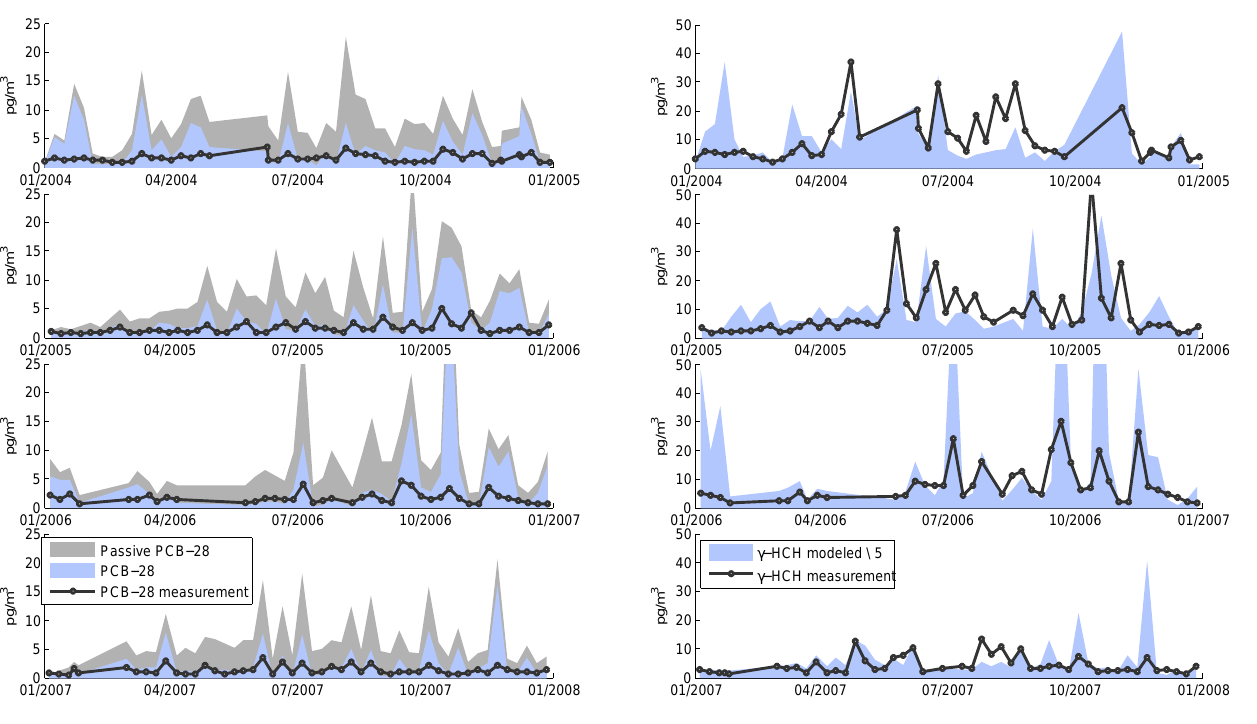
Fig. 5. Time series of modeled and measured PCB-28 [pgm − 3 ]. The grey area represents the concentrations of a passive PCB-28 tracer without removal processes, the blue area shows the modeled concentration of PCB-28 including removal processes, the black line with circles shows the measurements in pgm − 3 .